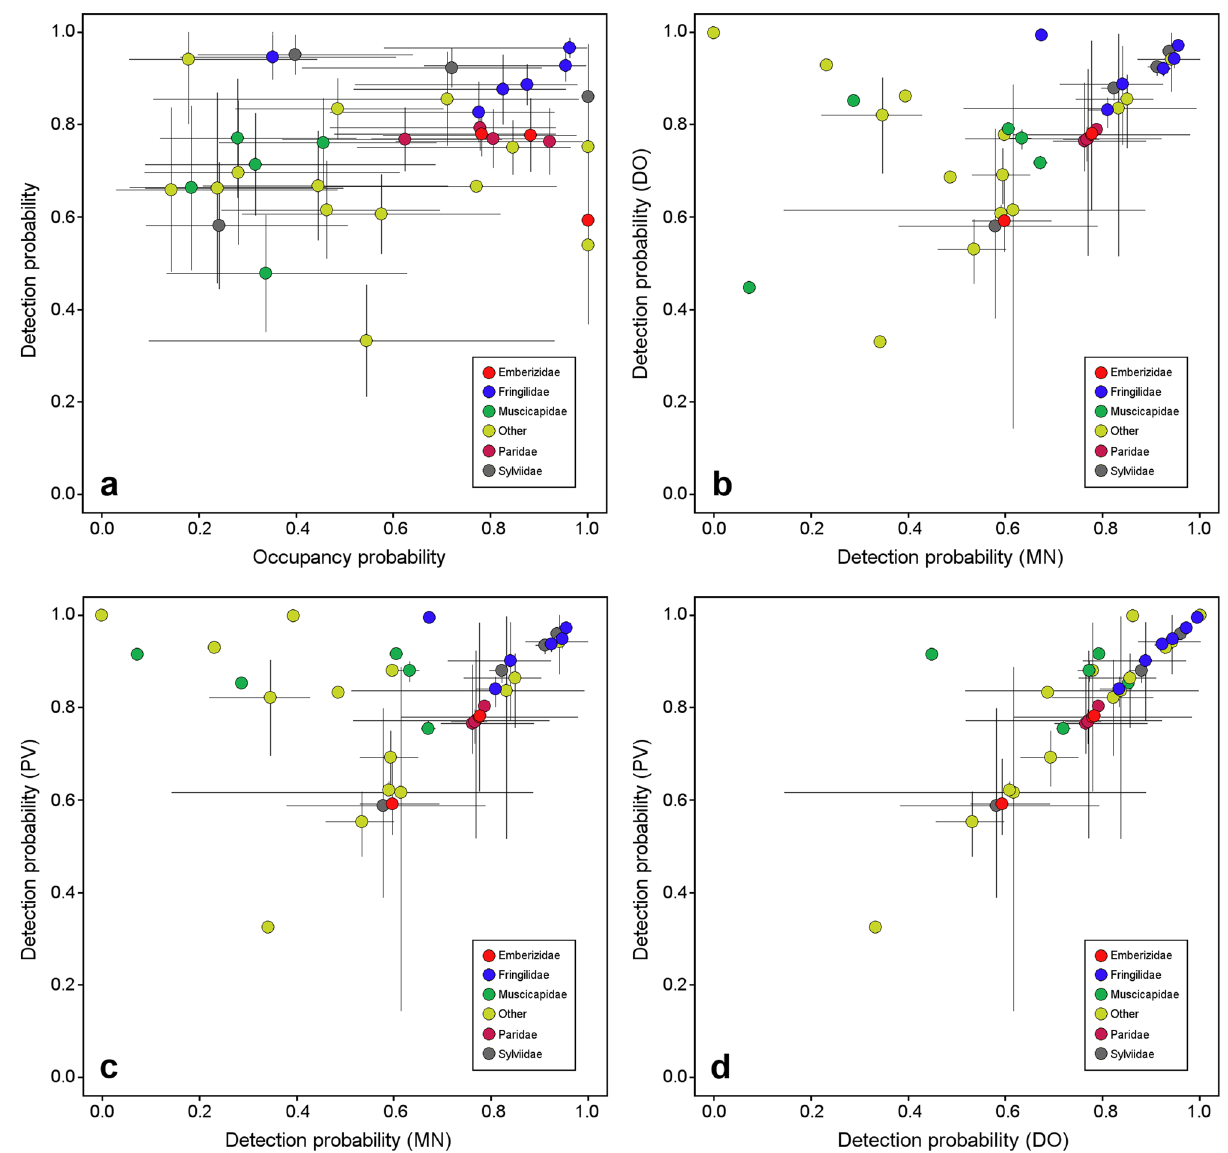
Figure 3. Occupancy and detection probabilities of 36 bird species recorded in pond surveys in south-eastern Spain. ( a ) Occupancy versus detection probabilities. Occupancy probabilities are model-averaged occupancy estimates (ψ). Detection probabilities are the mean of the nine method- and survey-specific, model-averaged detection estimates. Lines represent 95% confidence intervals. ( b–d ) Pairwise comparison of detection probabilities for mist netting (MN), direct observation (DO) and direct observation plus video monitoring (PV). Points represent the average of the three survey-specific estimates and lines represent the range. Point colour refers to avian family. Only the five families with the highest number of recorded species are indicated, while the remaining families are grouped as “other”. The figure was created in R (version 4.0.2, https ://www.R-proje ct.org/) and assembled with GIMP (version 2.10.14, https